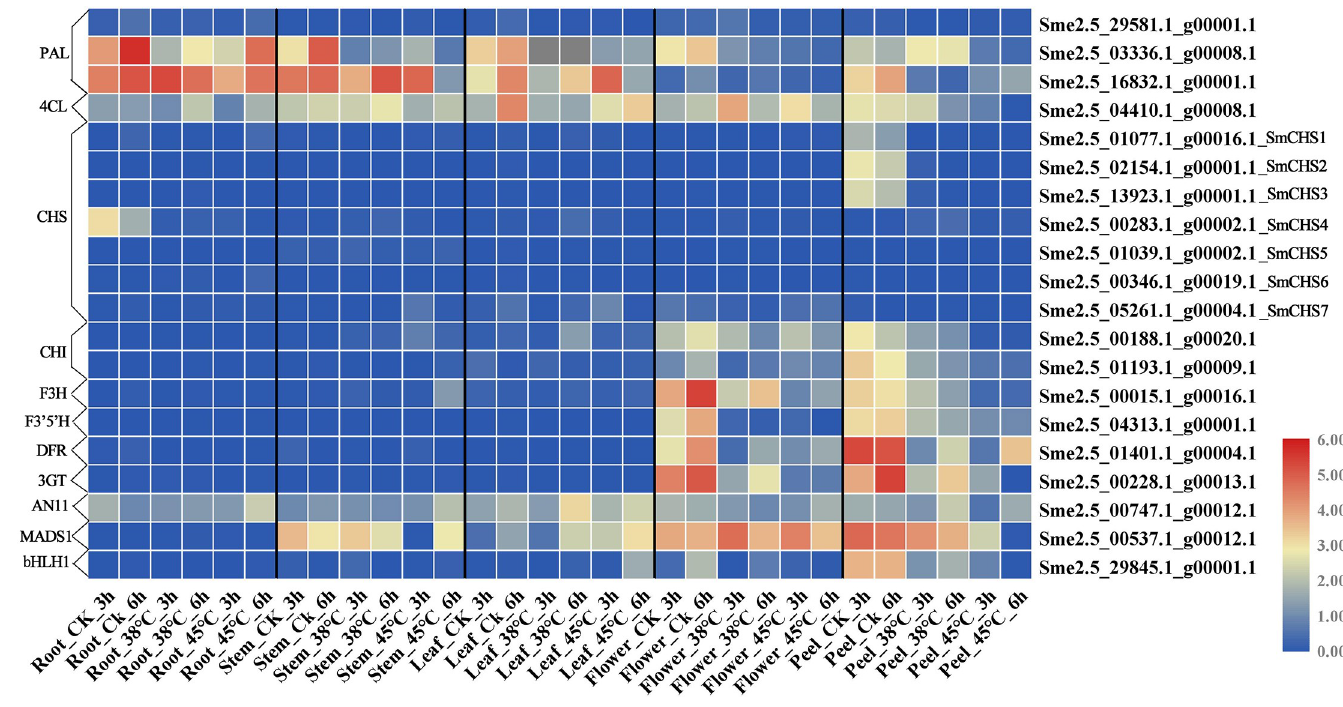
Fig 7. Expression profiles of 20 key anthocyanin biosynthesis genes in different tissues.